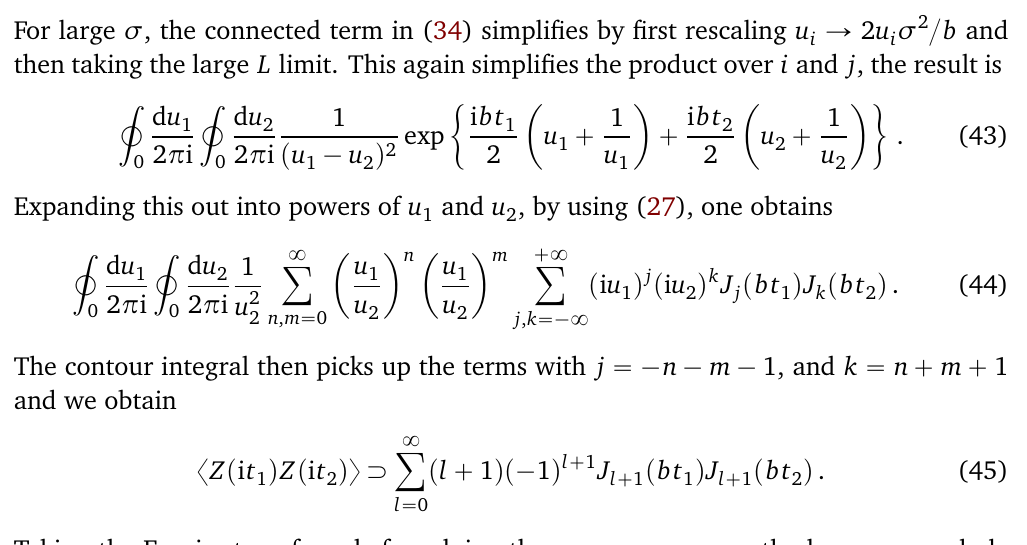
Figure 3: Spectral correlation R p E tom) for L “ 8 and σ “ 5,1,1 { 10 (left to right). The covariance T p E significant close to the diagonal axis, nearby eigenvalues repel; it interpolates be- tween a ridge and the diagonal deltas. The theory factorizes, because the covariance drops to zero everywhere, except on the location of the eigenvalues of H produces the required delta contact terms. The correlation R p E zero on the diagonal, testimony to quadratic level